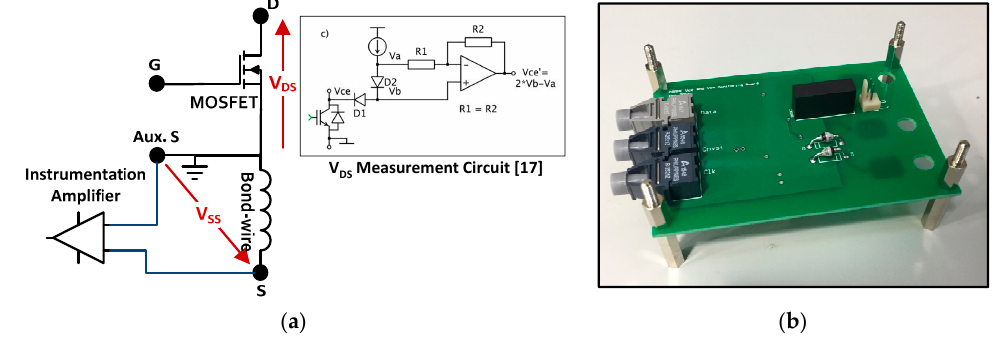
Figure 3. ( a ) Schematic for online V SS and V DS measurements; ( b ) Photo of prototype measurement board.